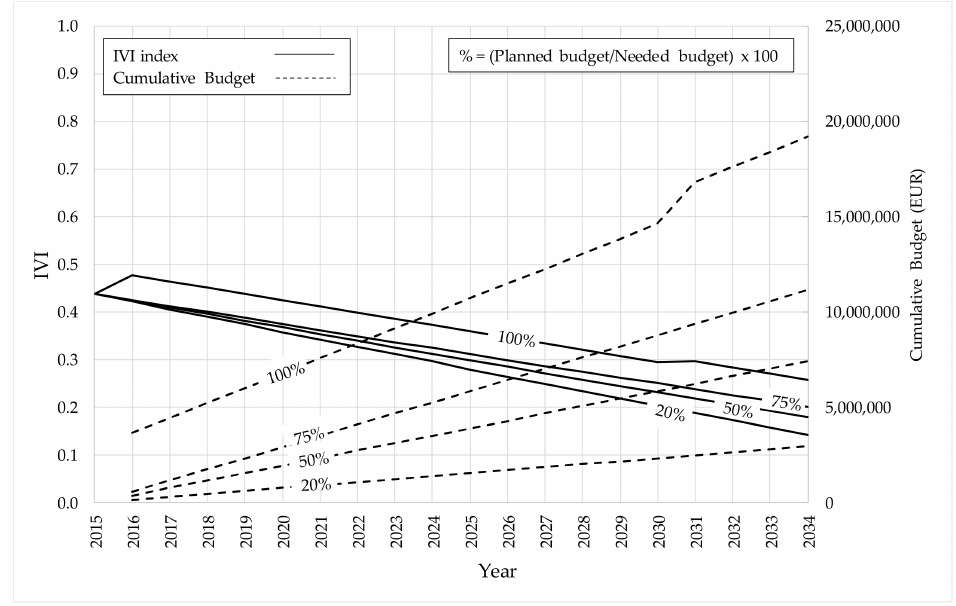
Figure 11. Asset 1 condition assessment with IVI under several future investment